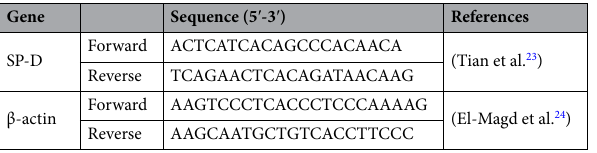
Table 1. Primers sequence used in our study. SP-D surfactant protein D, β-actin